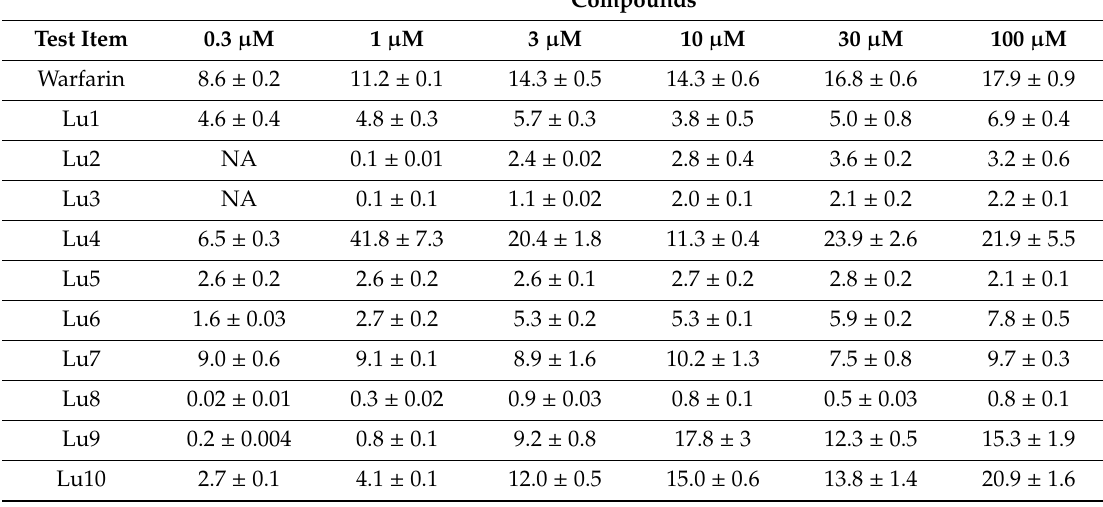
Table 2. Concentration-dependent change in binding to brain tissues for HSP90